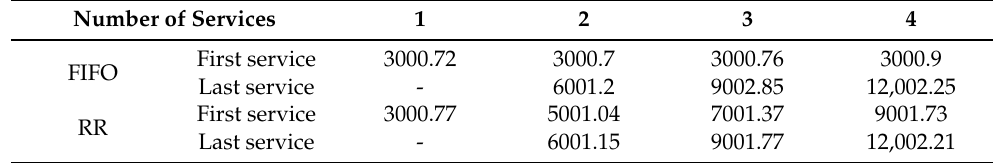
Table 2. Response times with a single timer.